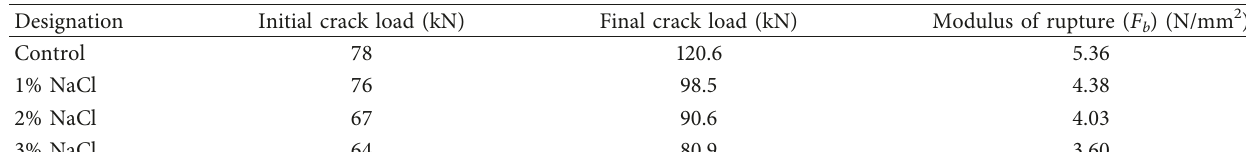
Figure 8: AC impedance curve for the rebar (a) and prestressed steel (b) in chloride-contaminated concrete. Table 3: Initial and final crack load for the flexural concrete beams.